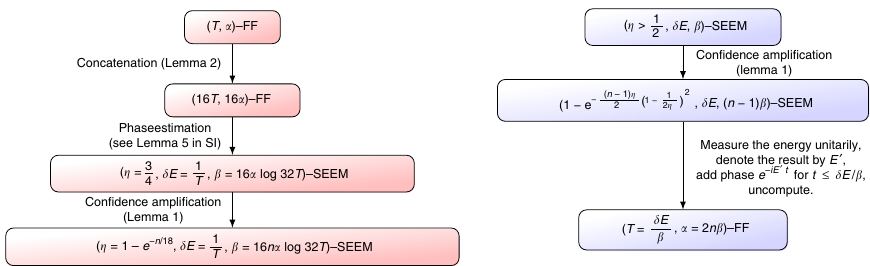
Fig. 7 Sketch of the equivalence proof in both directions. The boxes indicate the guaranteed parameters, and the arrows are accompanied by the lemmas used to derive